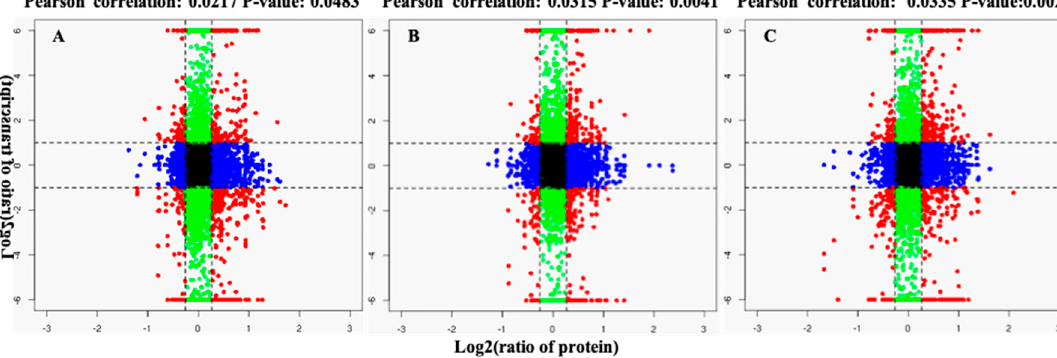
Figure 7. Transcriptome-proteome-associated analysis of gene expression in Pst-infected wheat leaf tissues. The x-axis indicates the level of DAP accumulation detected in the proteomic analysis, while the y-axis indicates the level of DEG expression detected in the transcriptome analysis. The Pearson correlation p-values are indicated above each plot. A, B, and C represent different analysis at 24, 48, and 72 hours after inoculation, respectively. Each plot is divided into nine quadrants (1, 2, 3 at the top; 4, 5, 6 in the middle; and 7, 8, 9 at the bottom, ordered from left to right), which indicate the correction of gene expression at the transcript and proteins levels. Table 2. The predicted candidate resistance priming gene in wheat variety N9134.